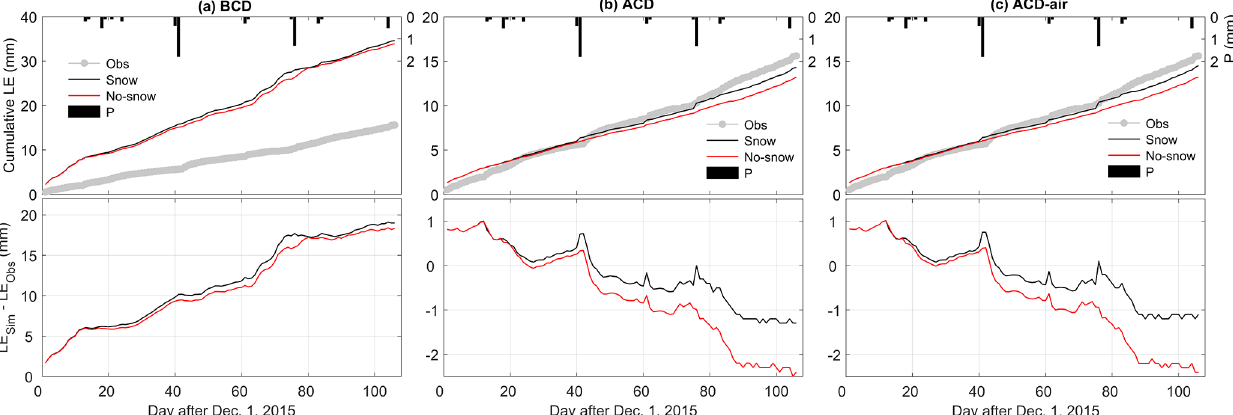
Figure 5. Time series of observed and model simulated surface cumulative latent heat flux ( LE ) using (a) BCD, (b) ACD, and (c) ACD-air soil models with and without consideration of the snow module (including precipitation). The top row shows the comparisons, and the bottom row shows the model bias of the cumulative surface LE .